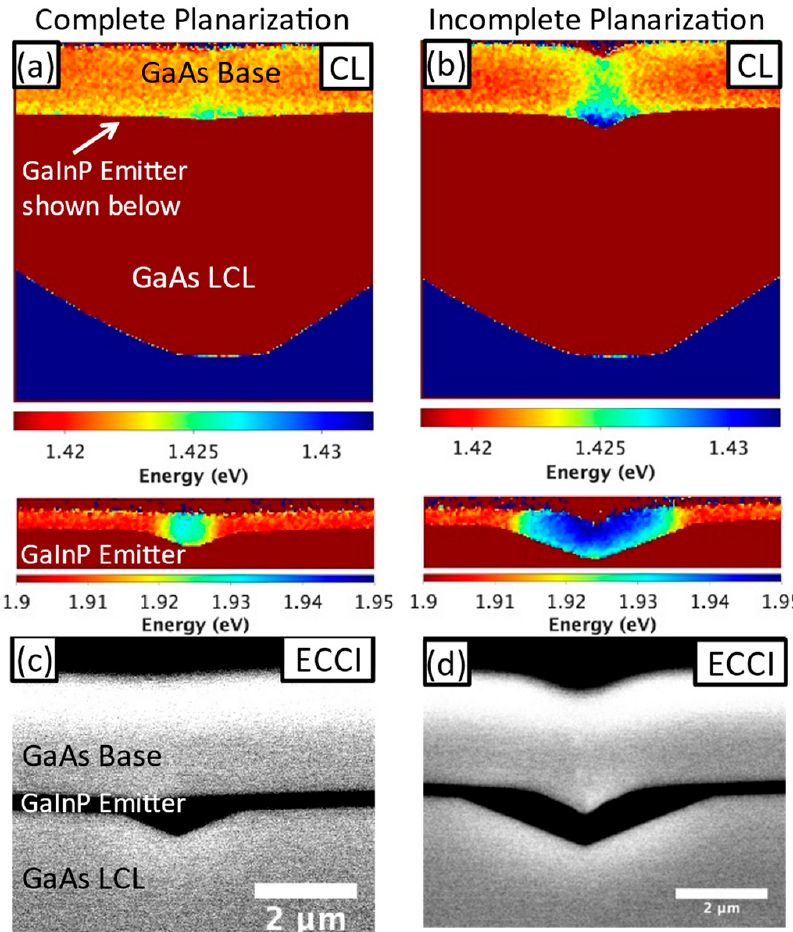
Figure 8. CL peak emission energy images of ( a ) complete and ( b ) incomplete planarized cross- sections. GaInP emitter is shown separately below. ECCI images of ( c ) complete and ( d ) incomplete planarized